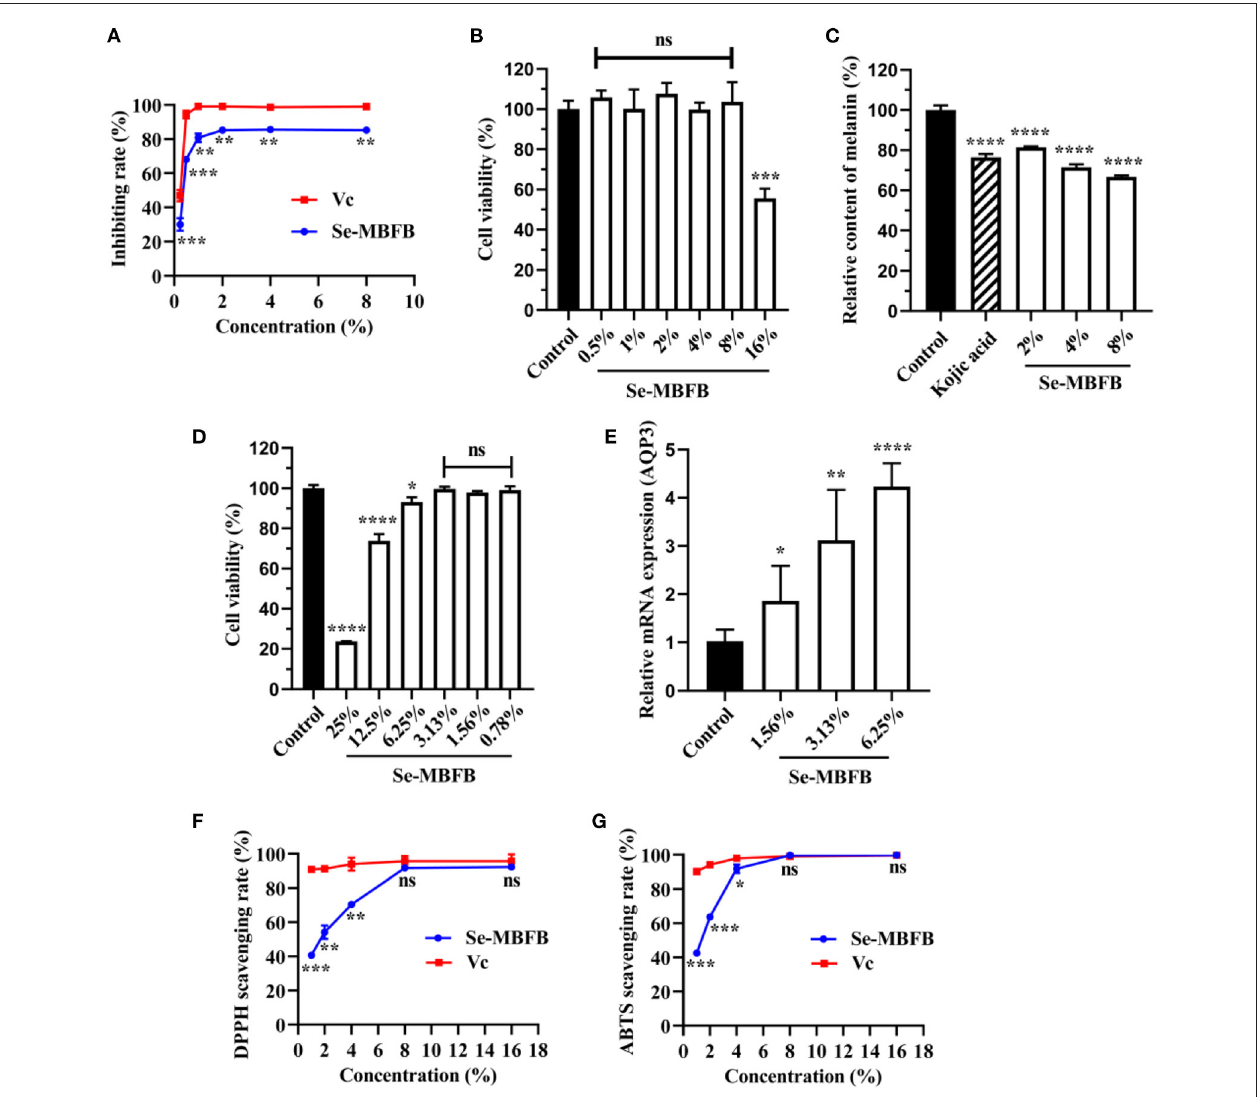
FIGURE 2 | (A) Comparison of tyrosinase inhibition rates between Se-MBFB and Vc; (B) effects of Se-MBFB on B16-F10 cell viability; (C) effects of Se-MBFB on melanin synthesis in B16-F10 cells; (D) effects of Se-MBFB on HDF cell viability; (E) effect of Se-MBFB on expression of AQP3 in HDF cells; (F) effect of Se-MBFB on DPPH free radical scavenging activity; (G) effect of Se-MBFB on ABTS free radical scavenging activity. A significant difference was presented with p < 0.05 compared with control or Vc group, ‘*’ represented p < 0.05, ‘**’ represented p < 0.01, ‘***’ represented p < 0.001, and ‘****’ represented p <